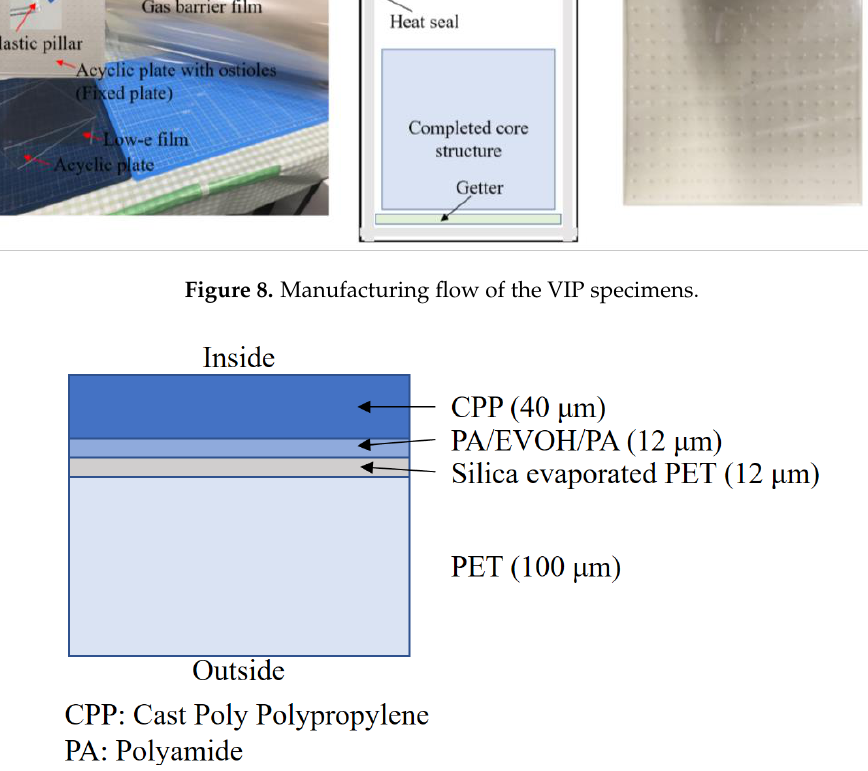
Figure 9. Component diagram of the gas barrier film.